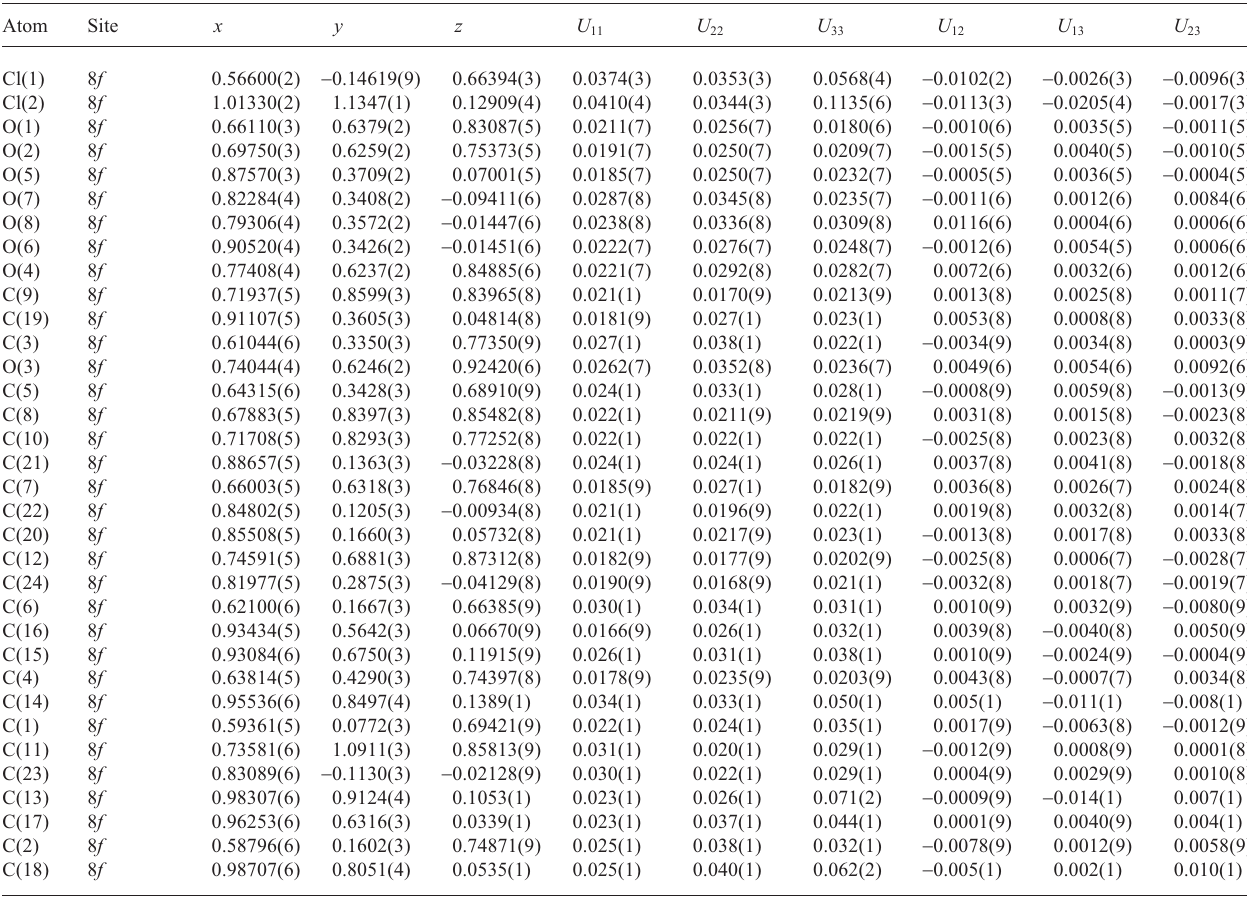
Table 3. Atomic coordinates and displacement parameters (in Å 2 )